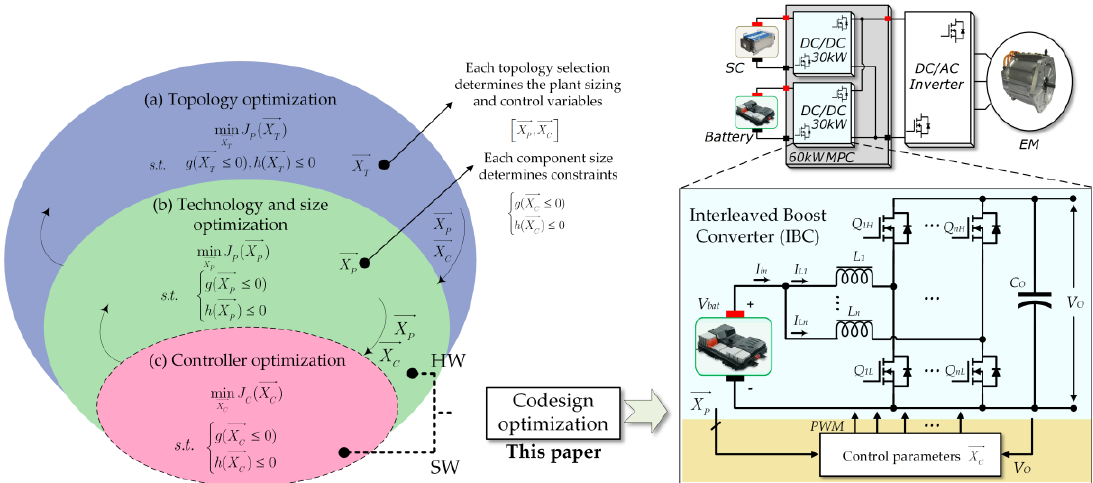
Figure 1. Sequential system-level design and coordination of HW sizing and SW controller optimization (codesign) for IBC.